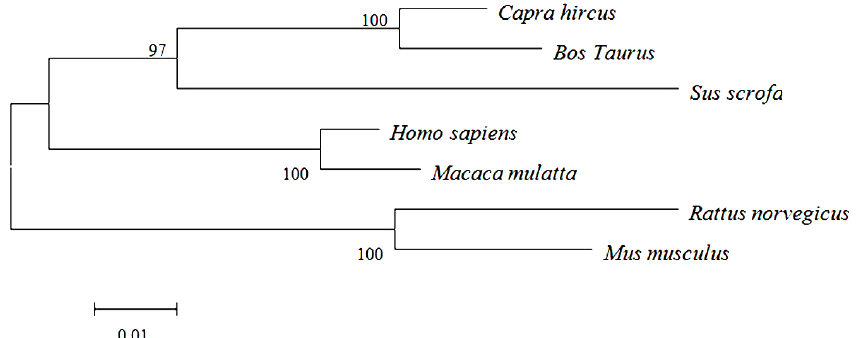
Figure 1. Phylogenetic tree of ELOVL1 . Goat ELOVL1 was aligned with other